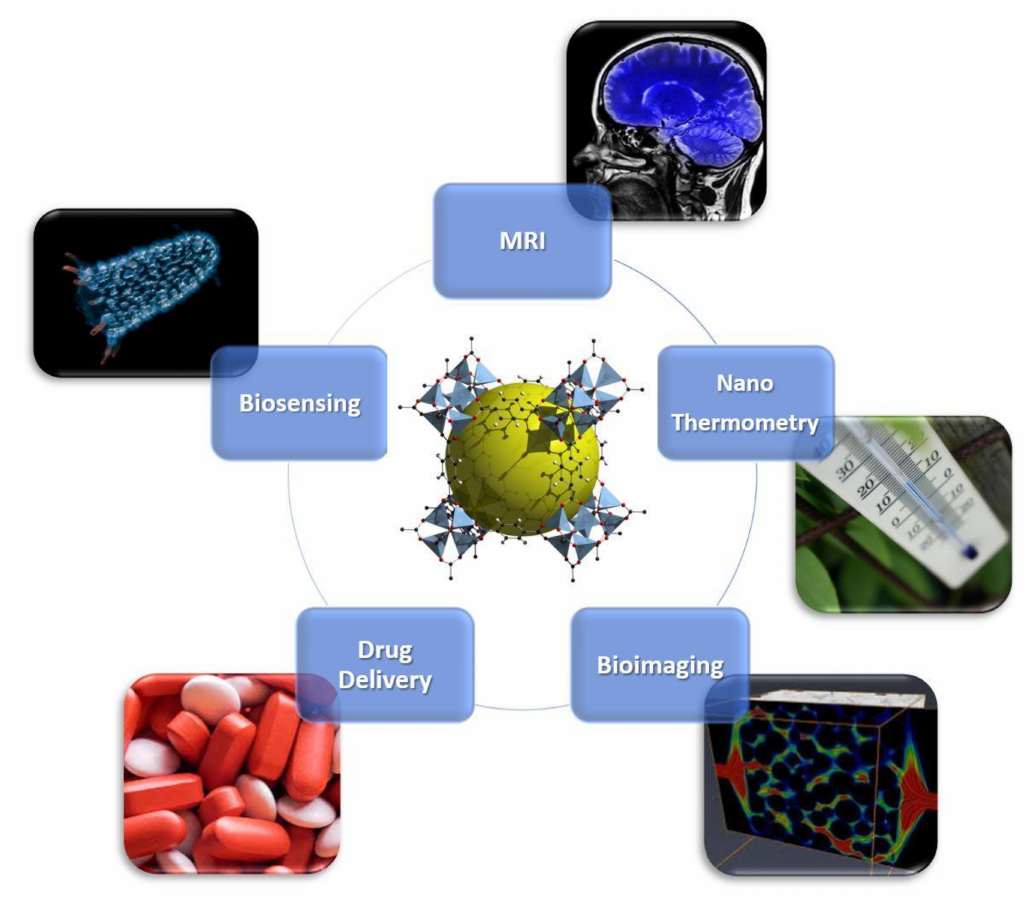
Figure 1. Overview of biomedical Applications of nanometal–organic frameworks